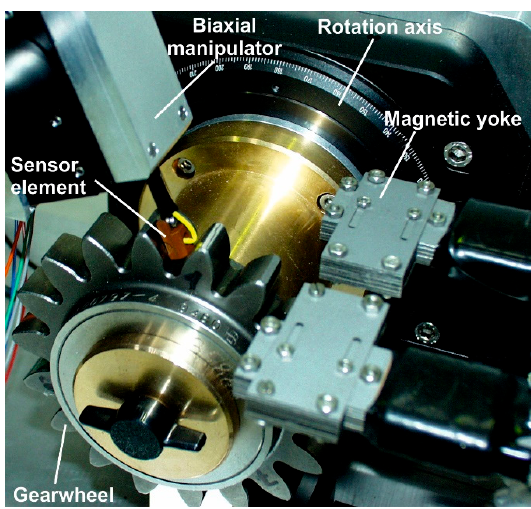
Figure 24. 3MA gearwheel scanner system. Appl. Sci. 2019 , 9 , x FOR PEER REVIEW Figure 25. Results of the calibration to depth ‐ dependent material properties: ( a ) hardness at depths of 0.1, 0.2, 0.3, 1.0, and 3.0 mm and ( b ) residual stress at depths of 0, 0.01, 0.02, 0.04, and 0.06 mm.